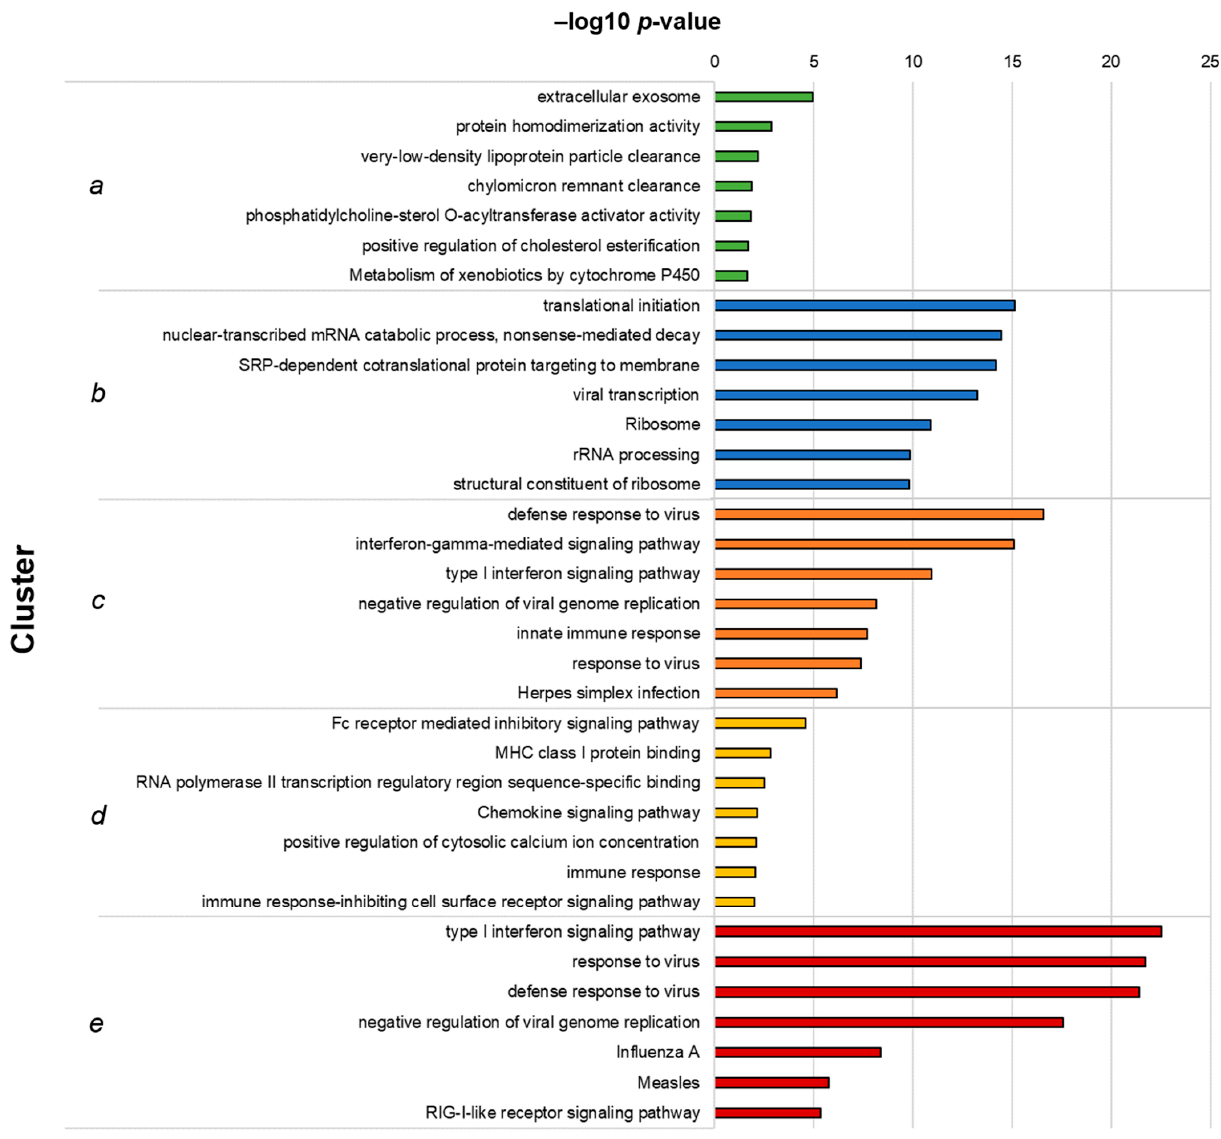
Figure 3. Top 7 GO terms and KEGG pathways identified in each cluster from Analysis 2. Hierarchical clusters (as presented in Figure 3C) were analyzed for functional enrichment. The clusters represent functions similarly up- (clusters ( c , e )) or downregulated ( b ) by live TBEV and I-TBEV, downregulated in I-TBEV-treated cells and upregulated in live TBEV-treated cells ( a ), or vice versa ( d ). The bars show the –log10 of the raw p -value.